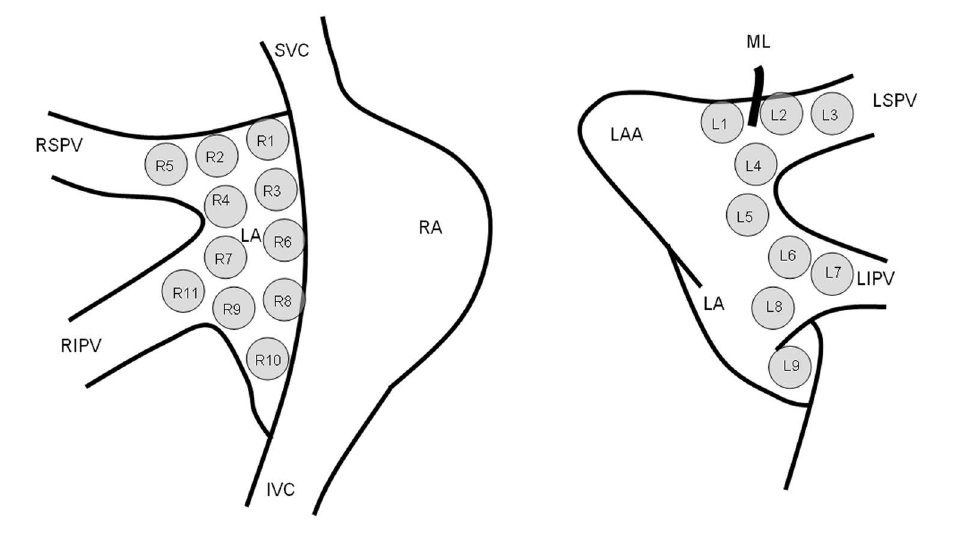
Fig. 1 - Sequence for applying rapid stimulation to detect GP. IVC=inferior vena cava; LA=left atrium; LAA=left atrial appendage; LIPV=left inferior pulmonary vein; LSPV=left superior pulmonary vein; ML=Marshall ligament; RA=right atrium; RIPV=right inferior pulmonary vein; RSPV=right superior pulmonary vein; SCV=superior vena cava.